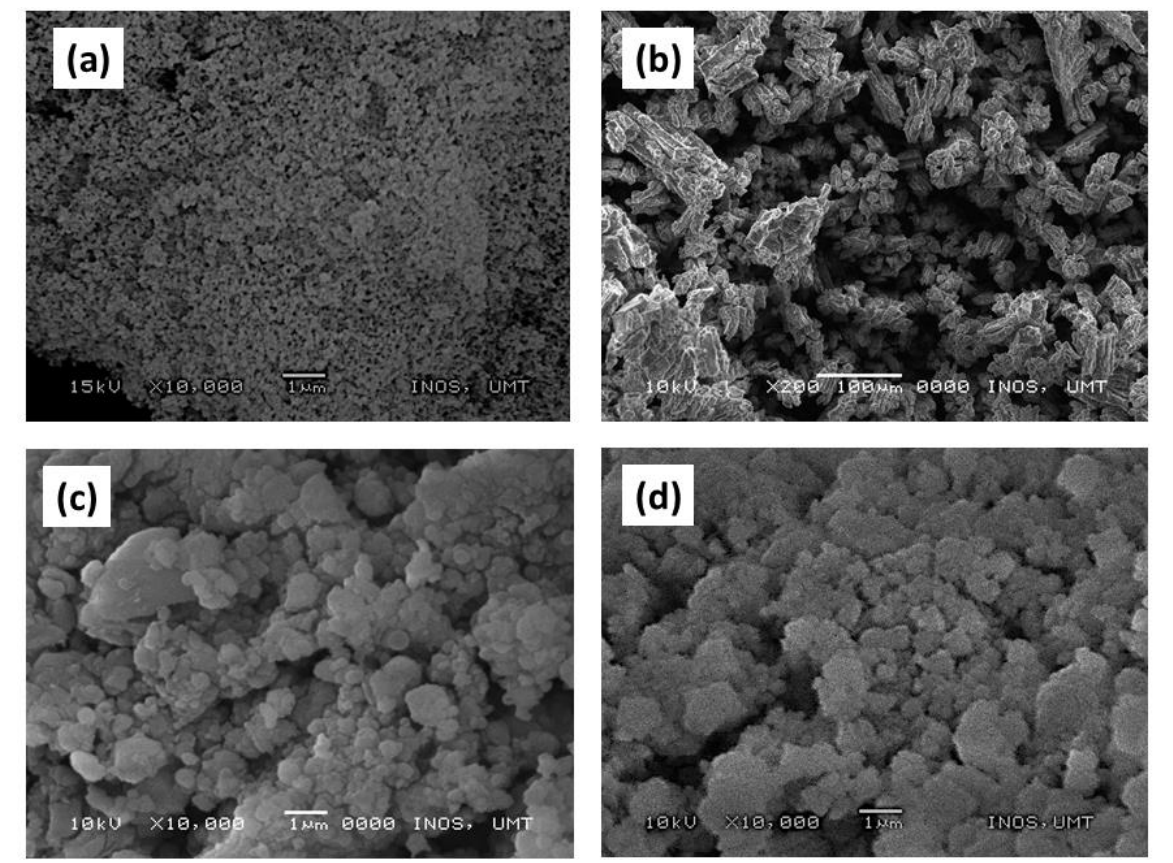
Figure 4. The morphological structures of ( a ) as-obtained TiSiO 4 , ( b ) as-obtained LiAlH 4 , ( c ) post- milled LiAlH 4, and ( d ) LiAlH 4 added with 10 wt% TiSiO 4 . The particle size distribution of the TiSiO 4 , added, and undoped LiAlH 4 samples were determined using the Image J software, as demonstrated in Figure 5. Based on the histogram shown in Figure 5a – d, the estimated average particle sizes for the as-obtained TiSiO 4 , as-obtained LiAlH 4 , post-milled LiAlH 4 , and LiAlH 4 added with 10 wt% TiSiO 4 were determined to be 6.10, 81.58, 61.71, and 28.13 µm, respectively. These findings demonstrated that the addition of 10 wt% TiSiO 4 to LiAlH 4 significantly reduced particle size. Previous studies by Ahmad et al. [22] and Cai et al. [48] stated the added LiAlH 4 increased the rate of hydrogen diffusion, which resulted in fast dehydrogenation kinetics and low activation energy. Additionally, its smaller particle size results in a larger surface area and more grain boundaries [36,38,49].